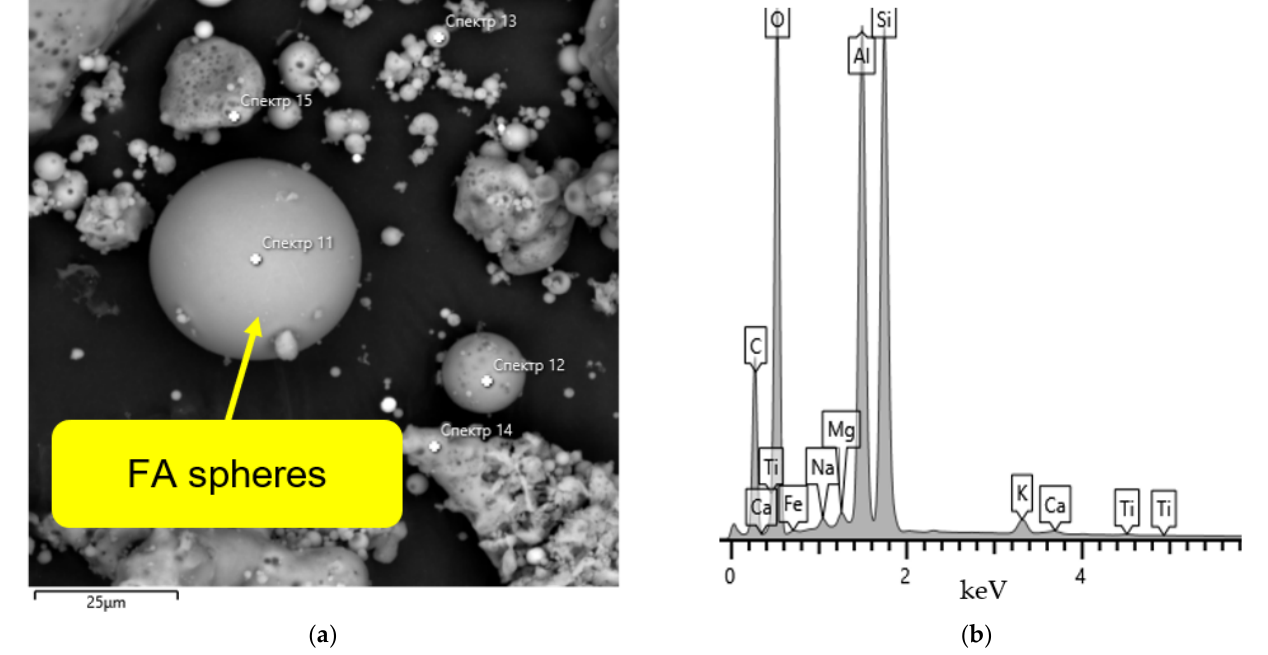
Figure 2. ( a ) SEM images and ( b ) EDX measurements of FA. GGBS was collected from the ArcelorMittal company in Temirtau city (Kazakhstan).